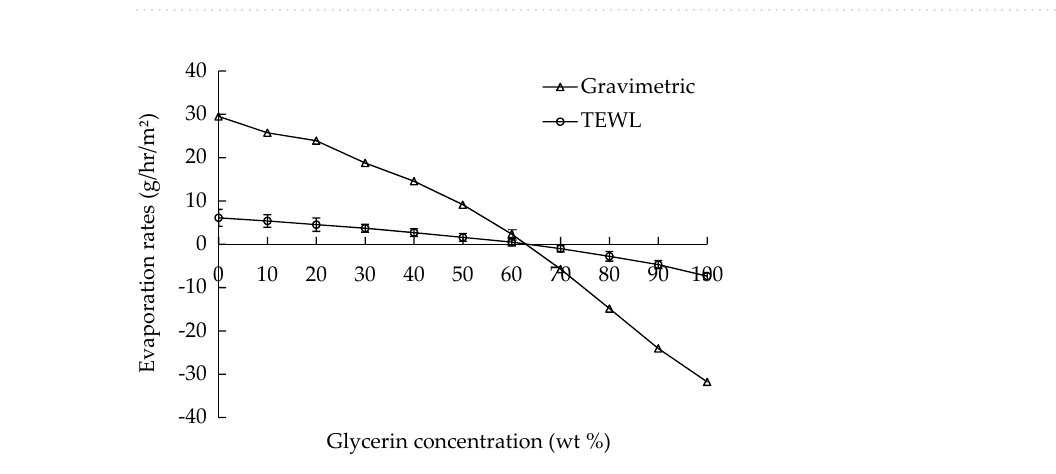
Figure 3. Evaporation rate of glycerin solutions of various concentrations measured by using gravimetric and TEWL